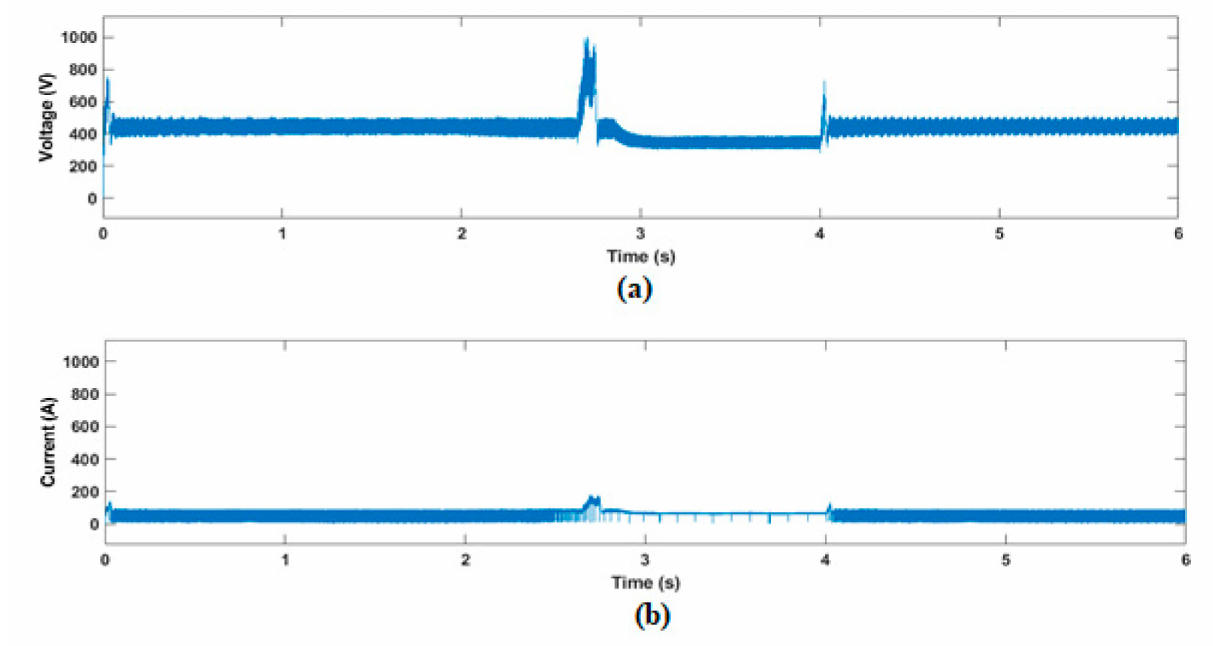
Figure 27. ( a ) Output voltages and ( b ) current of boost converter for variables speed during Scenario